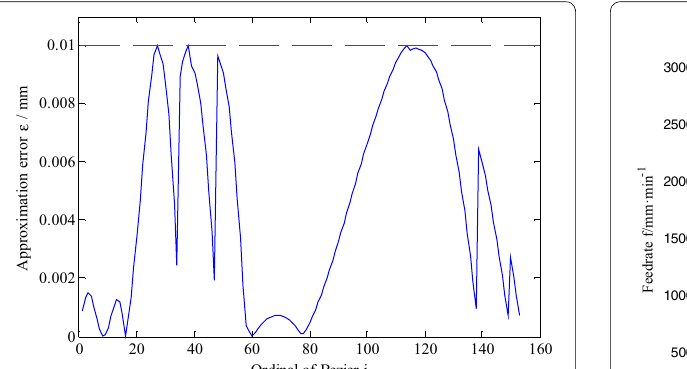
Figure 8 Approximation errors of the Bézier curve